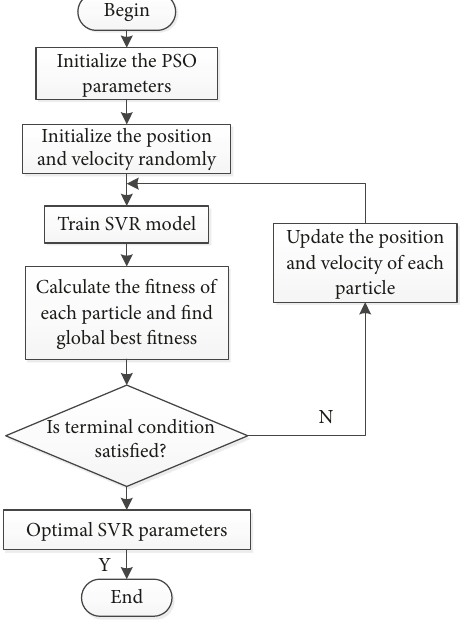
Figure 2: The process of optimized PSO-SVR.